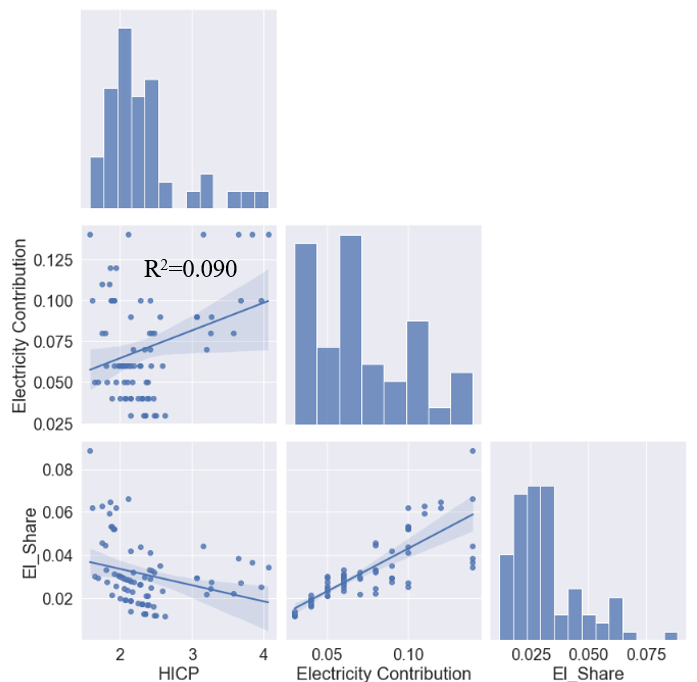
Figure 4. Dstributions and scatterplot between electricity share on HICP(El_share), electricity contribution to HICP as given by Eurostat and HICP in the period prior 2009. Source dataset: Eurostat: PRC_HICP_CTRB. Figure 5 plot electricity contribution, HICP, the share of electricity contribution on HICP and histograms for each time series from 2010 to the end of 2021. After 2009, the variation of electricity contribution explains 69% of the HICP variation.